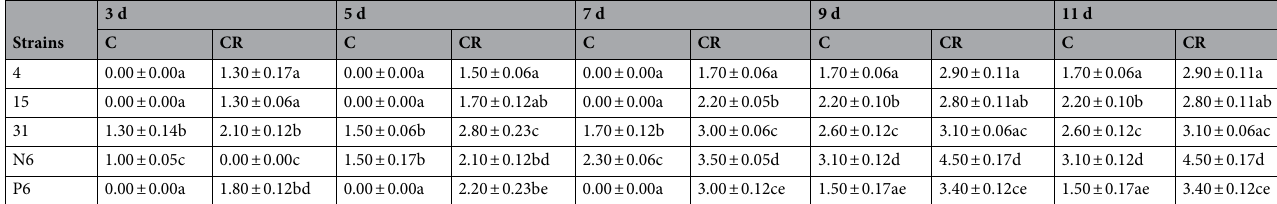
Table 1. Diameter changes of colony and chromogenic circles of different strains on selective media indicating lignin degradation ability over time (cm). C is for Circle of the colony; CR is for Color ring. Mean values are marked with different lower case letters are significantly different ( P < 0.05).